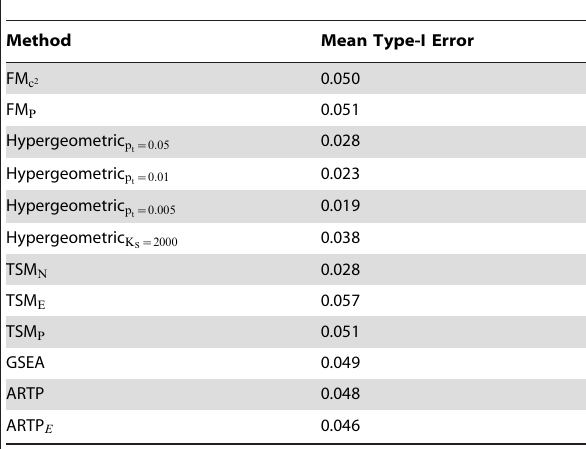
Table 1. Mean type-I error of the methods.